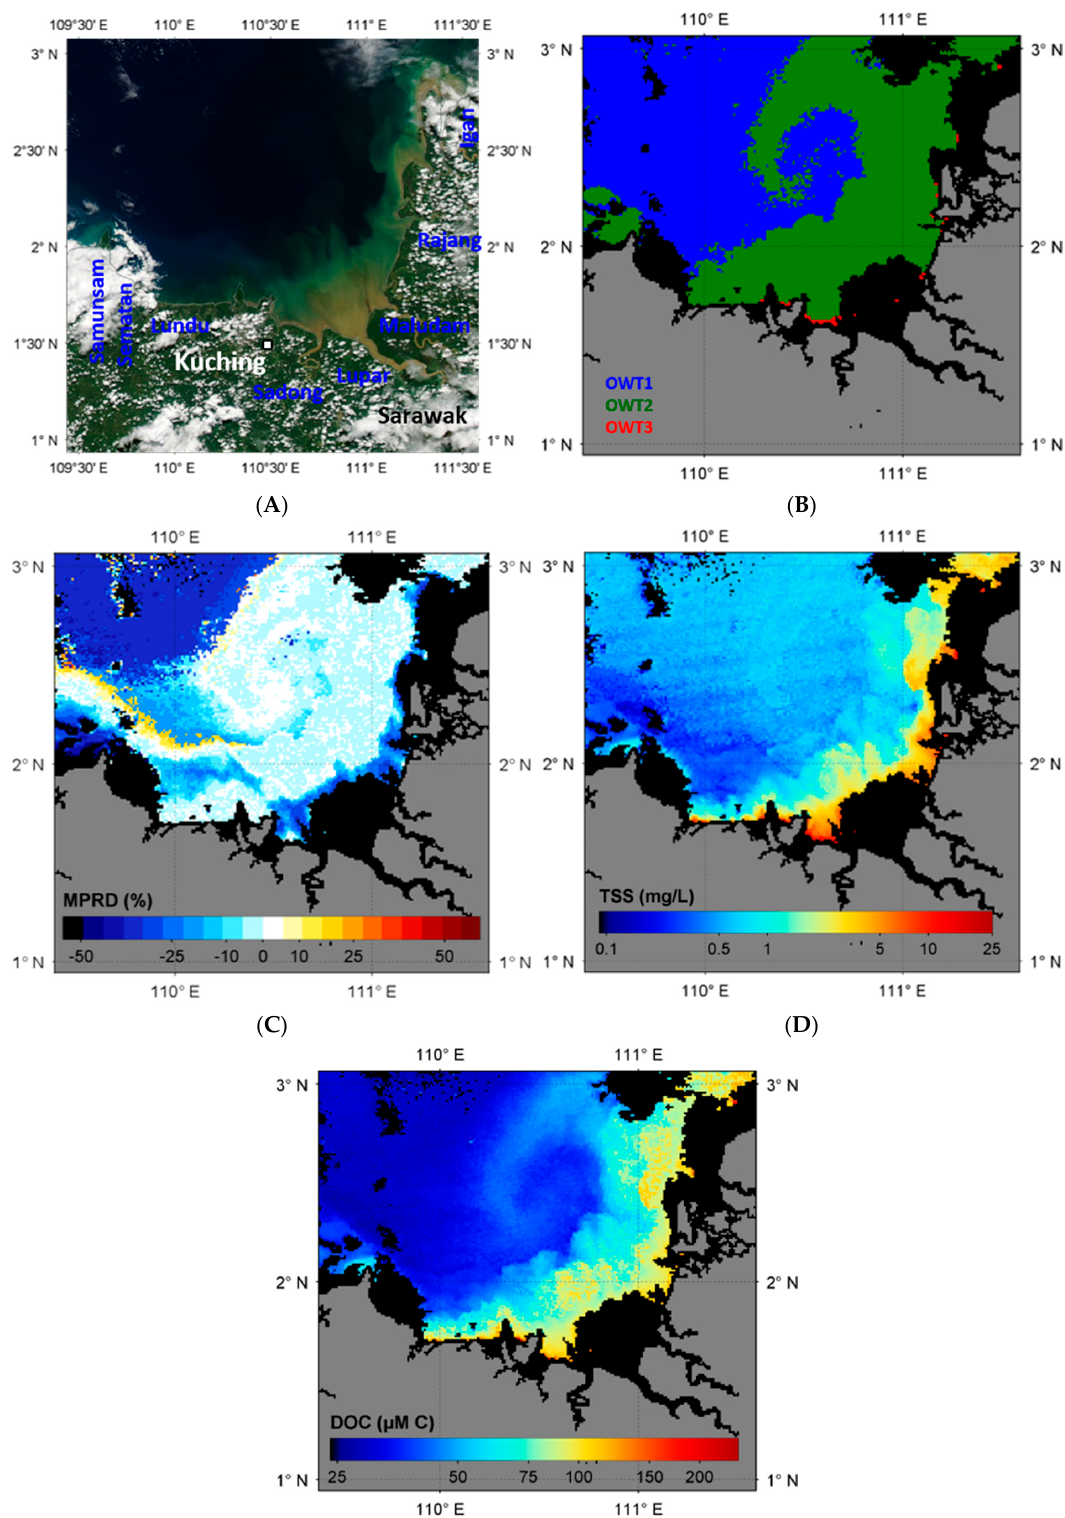
Figure 10. Demonstration of the optical inversion model applied to MODIS Aqua. ( A ) True-colour image of MODIS Aqua from 14 June 2017, ( B ) optical waters types detected in Sarawak coastal waters, ( C ) mean percent relative deviation between backscattering albedo (uT) observed by MODIS Aqua and simulated using the our Sarawak optical inversion model (iSAM), and spatial maps of ( D ) TSS and ( E ) DOC concentrations estimated using